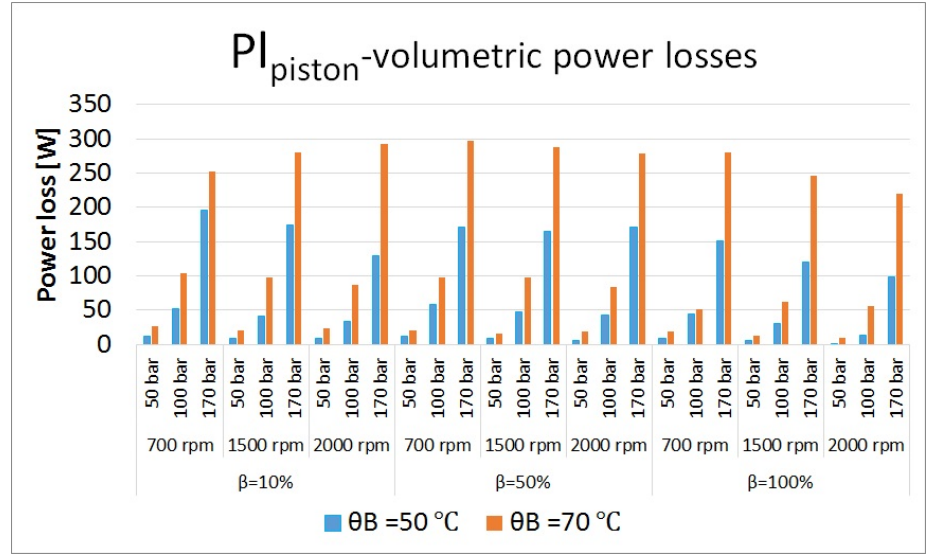
Figure 24. Total power losses in piston/cylinder bore interfaces at different operating conditions.